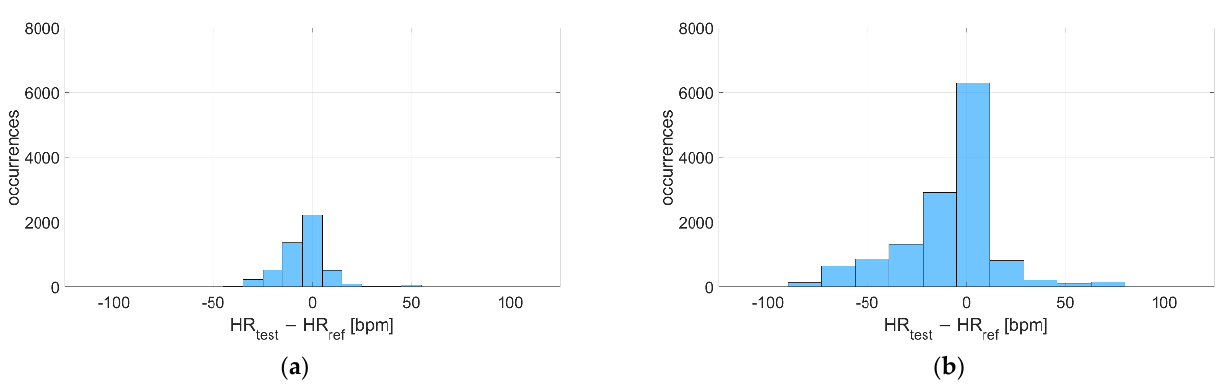
Figure 14. Distribution of deviations related to ( a ) Resting and ( b ) During activities, including recordings both at in-water and dry conditions performed with Polar Vantage V2 (reference instrument: Polar H10).